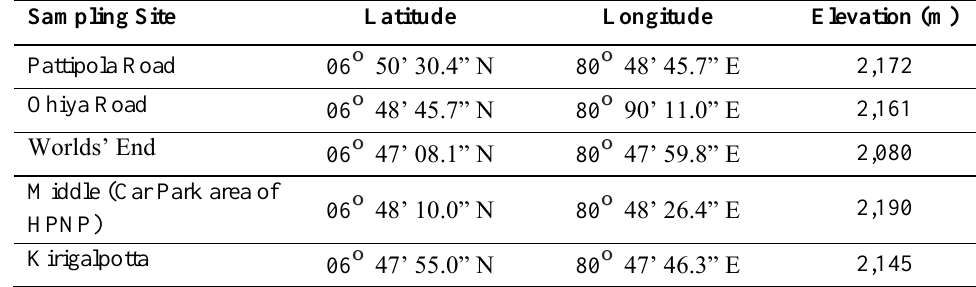
Table 1: Location characteristics ( latitude, longitude and elevation) of the five air sampling points in HPNP.